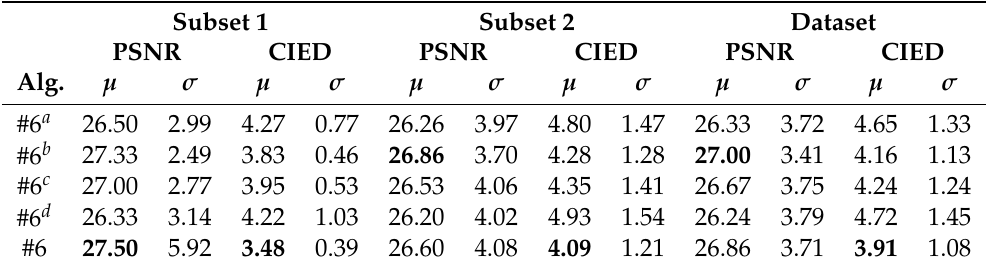
Table 5. Mean and standard deviation of the PSNR and CIEDE2000 (CIED) scores for each algorithm. Best results highlighted in bold.